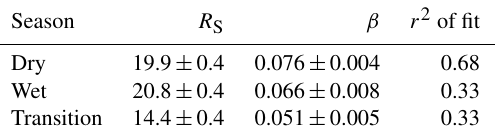
Table 2. Parameterization of total OH reactivity in dependence on temperature: coefficients for the equation R = R S exp (β [ T − T S ] ) , where R is total OH reactivity, T is temperature in degrees Cel- sius, T S is standard temperature (25 ◦ C), R S is total OH reactivity at standard temperature, and β is an empirical